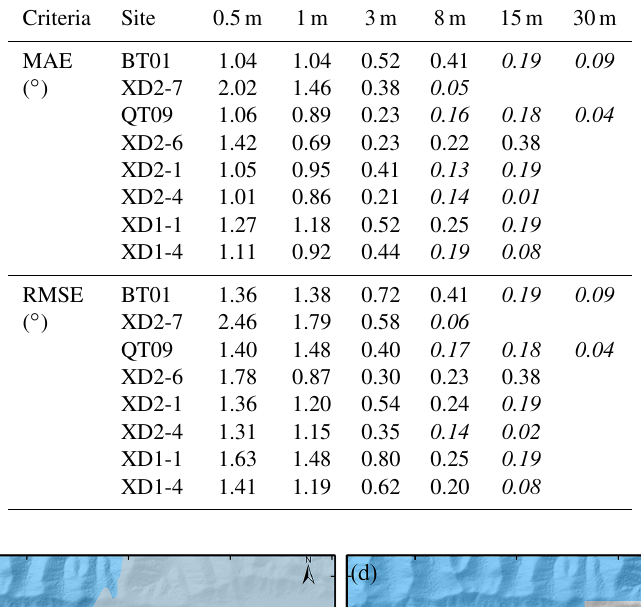
Table 1. Error metrics for assessing daily average ground temperature at different depths derived from observation and simulated for indi- vidual calibration and validation sites (good criteria values < 0 . 20 ◦ C are displayed in italics).